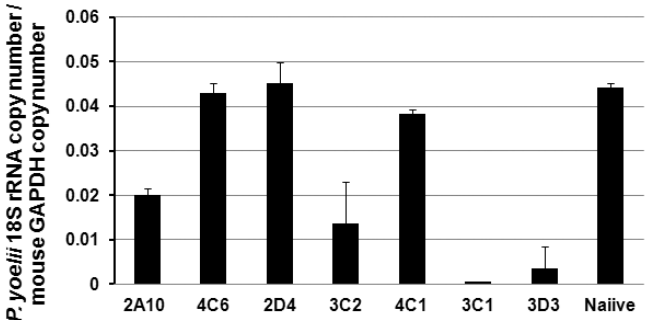
Figure 4. In vitro neutralization assay. 2 × 10 4 PfCSP/Py sporozoites were pre-incubated with 100 µ g of each mAb, and then added to Hepa1-6 cells. Forty-two hours post infection, liver stage parasite